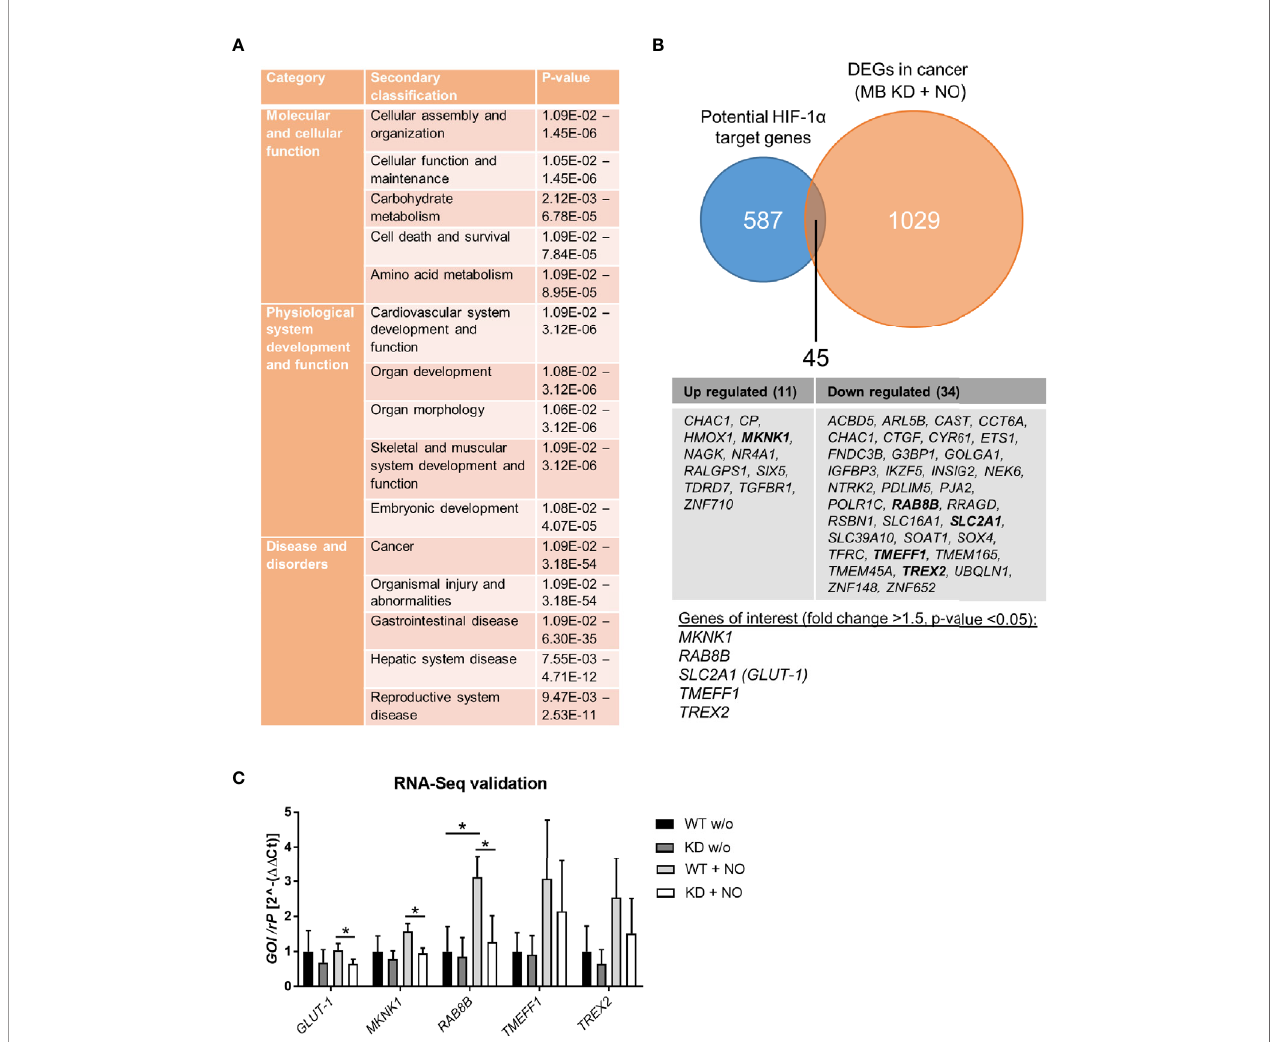
FIGURE 6 | RNA-Seq analysis of MB knockdown cells after treatment with NO. MDA-MB-468 cells were transfected with Hs_MB_6 FlexiTube siRNA (KD) or control siRNA (WT) and subsequently challenged with 500 μM GNSO for 6 h. (A) Ingenuity pathway analysis (IPA) showed signi fi cantly enriched annotations classi fi ed into three categories: molecular and cellular function, physiological system development and function, and disease and disorders. (B) 1029 differentially expressed genes (DEGs) of the cancer network were compared to 587 potential HIF-1 a target genes revealing 45 genes that were altered by a combination of MB KD and NO treatment. Of these, fi ve genes were identi fi ed as genes of interest with a fold change >1.5 and p-value < 0.05. (C) Expression levels of the genes of interest ( SLC2A1/GLUT-1, MKNK1, RAB8B, TMEFF1 , and TREX2 ) were validated by qPCR, showing a signi fi cant downregulation for SLC2A1/GLUT-1, MKNK1 , and RAB8B under MB KD conditions. As control, WT and MB KD cells were incubated without NO to show NO-mediated effects. Mean +/- SD, n = 4 in 2 independent experiments. *p < 0.05 as